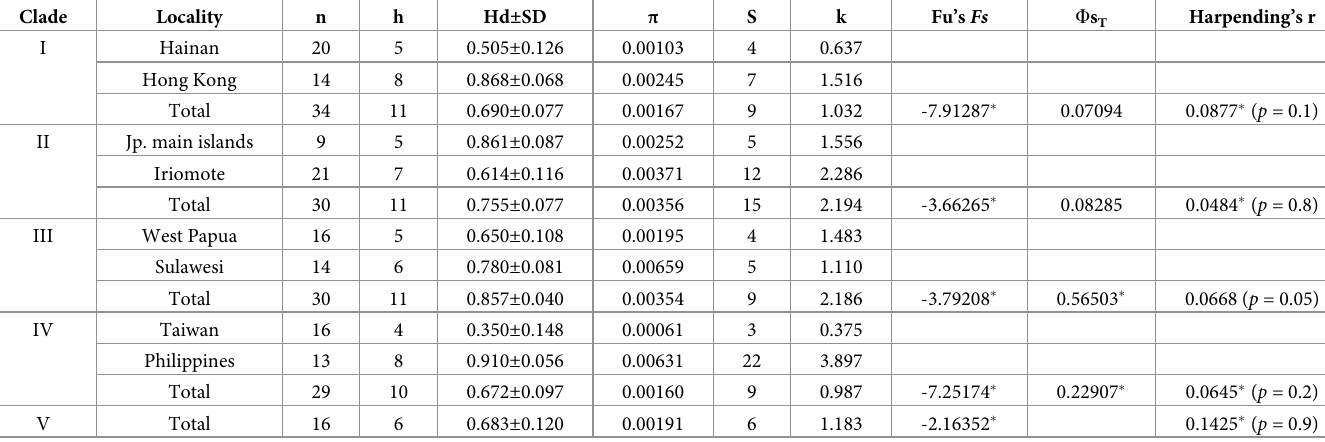
Table 1. Diversity indices. Statistical diversity indices (in five here recovered phylogenetic clades and main localities of each clade) and neutrality tests (Fu’s Fs) (in the five clades) based on 618 bp of Cox1 (the 3’ end). Indices were calculated with DnaSP 5.10, and the neutrality test carried out with ARLEQUIN 3.5. Pairwise F ST values among the main populations of each clade and Harpending’s raggedness index were calculated in ARLEQUIN 3.5.2.2. Clade